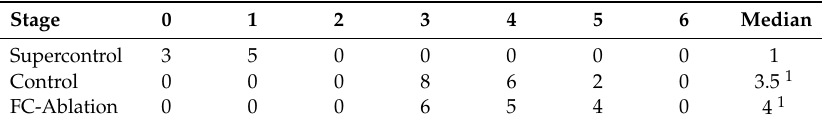
Table 1. Staging according to Ishak et